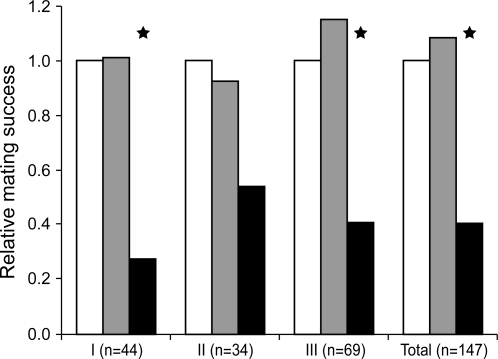
Mating success of sham-op (grey bars) and op-males (black bars) relative to that of stock males (white bars).Three trials (I to III) were performed with butterflies drawn at random from the stock population. Stock male mating success is set at 1. The total number of matings (n) is given for each trial. G-test significance: asterisk, p<0.05.